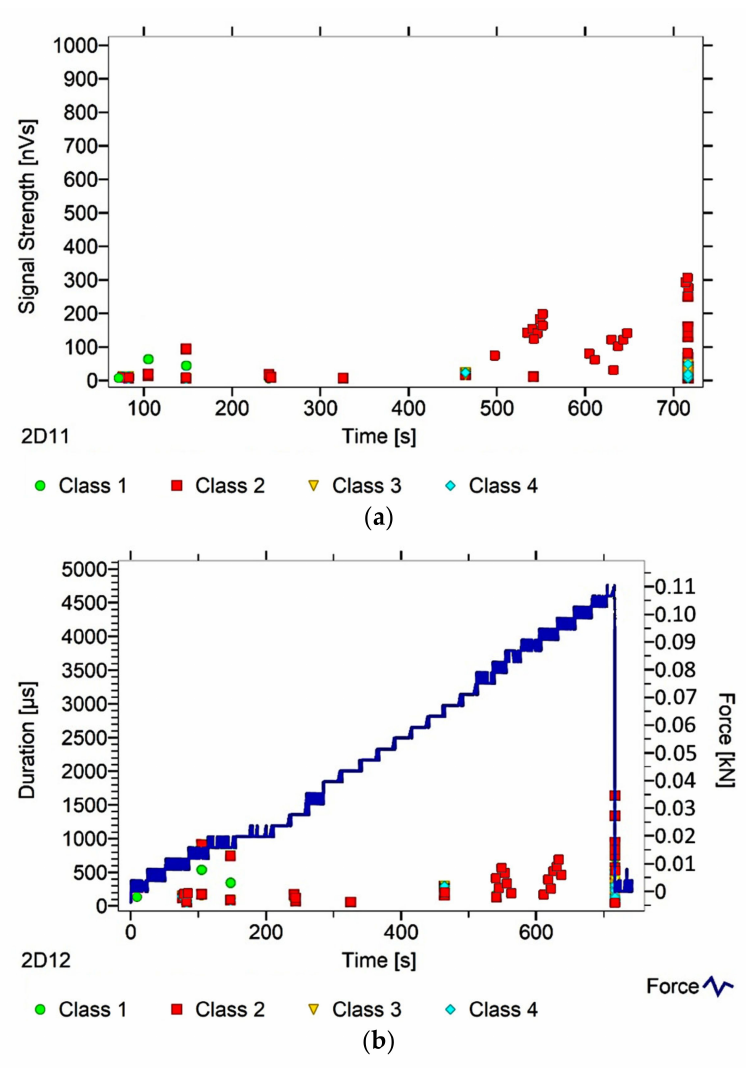
Figure 6. AE signal graphs for the mock BP sample: ( a ) signal strength distribution in time; ( b ) signal duration distribution in time, with plotted force increment curve.